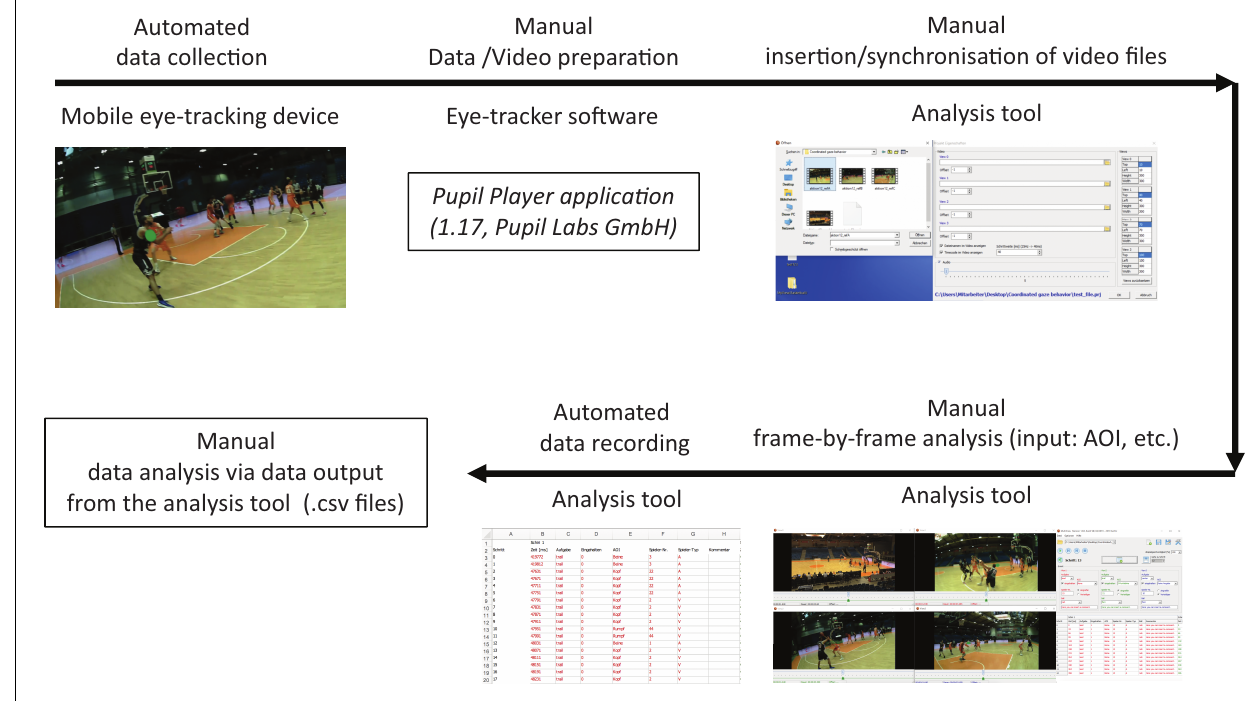
as the ball, the basket, another referee, the scorer’s table, defending or attacking players, the zone, and the three- point